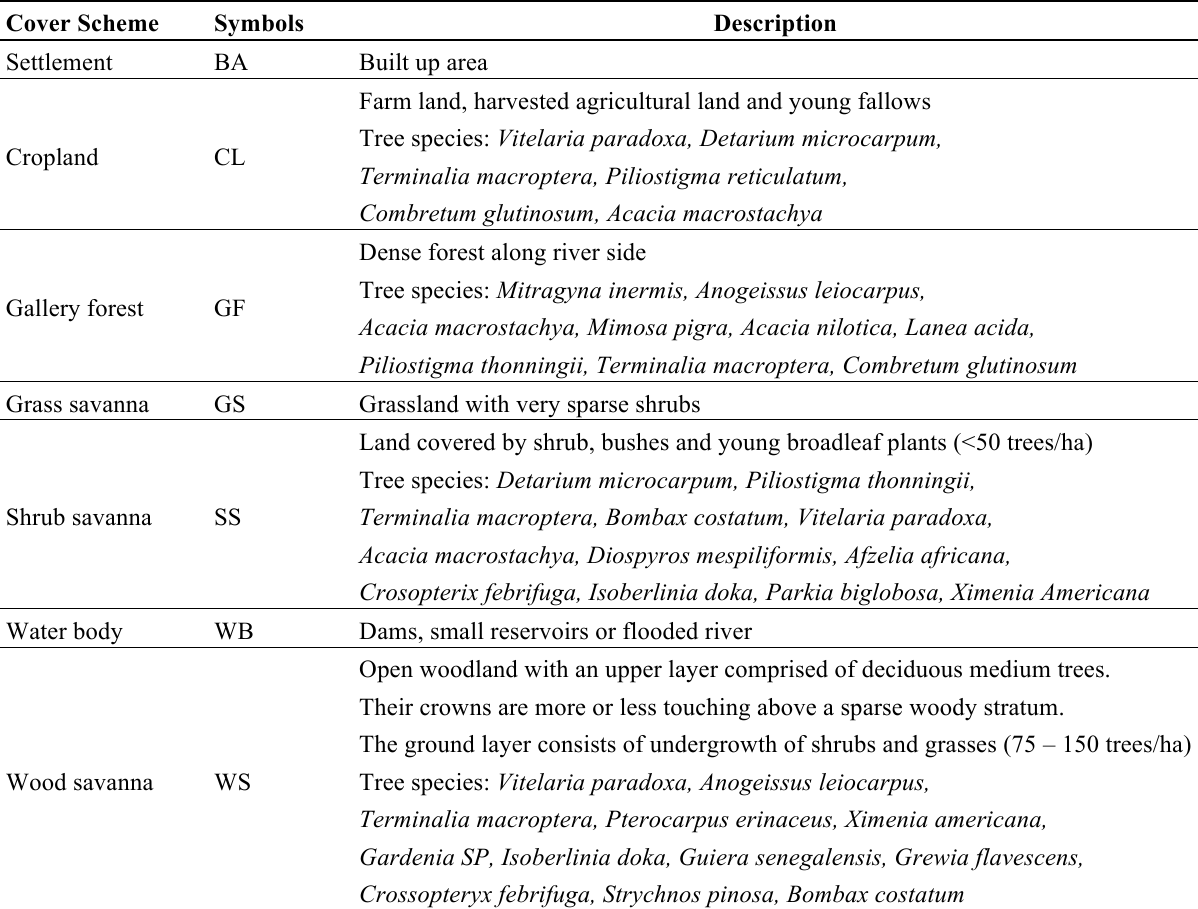
Table 1. Cassou land cover